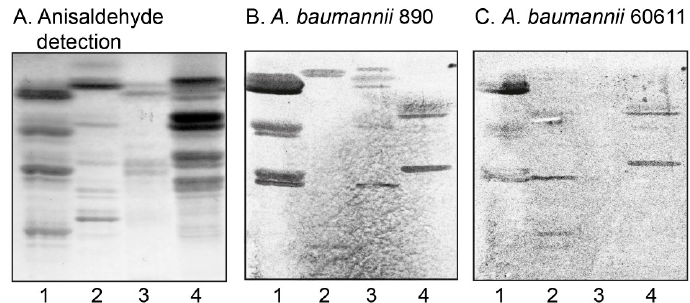
Figure 1. Screening for Acinetobacter baumannii carbohydrate recognition by binding to glycosphingolipids on thin-layer chromatograms. Chemical detection by anisaldehyde ( A ), and autoradiograms obtained by binding of A. baumannii strain CCUG 890 ( B ), and A. baumannii strain